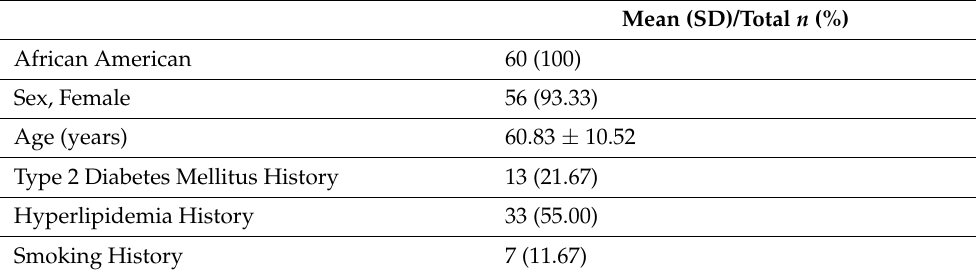
Table 1. Participants’